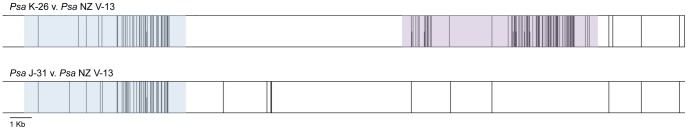
Shared and unique SNPs in Psa K-26 and J-31 compared to Psa NZ V-13.Sample view from Artemis showing SNPs from Psa J-31 and K-26 aligned against a ∼30 kb region of the NZ V-13 genome. Each line represents a SNP that distinguishes J-31 and/or K-26 from NZ V-13. Over this region, K-26 differs from NZ V-13 by 155 SNPs; J-31 differs by 65 SNPs. In the blue region there are 50 SNPs that distinguish J-31 and K-26 from NZ V-13. Of these, J-31 and K-26 are identical at 42 positions. GENECONV predicts that this region represents a gene conversion event between J-31 and K-26. The purple region denotes a gene conversion event into K-26 from a strain outside the set analyzed here. The set of Artemis input files allowing representation of the full set of SNPs, coverage of SNPs and regions identified by GENECONV as statistically supported regions involved in gene conversion events are available as Supplementary Dataset 1.